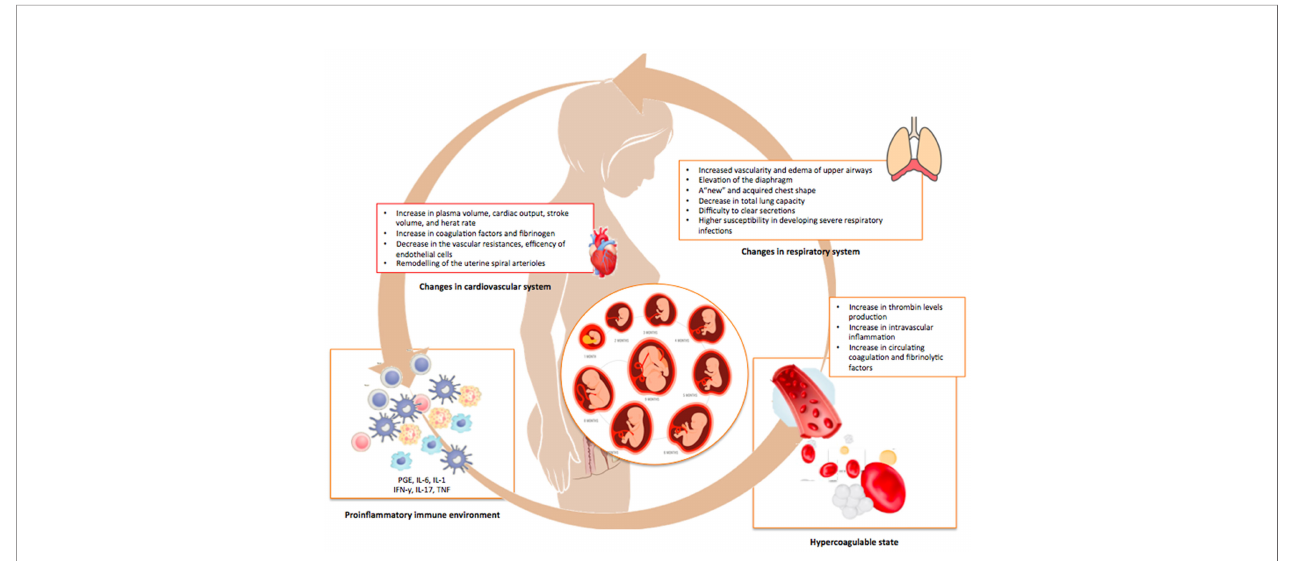
FIGURE 1 | Physiologic adjustments occurring during pregnancy. This illustration summarizes the multiple and profound changes in the immune, pulmonary, cardiovascular, and coagulation systems of the mother occurring during normal pregnancy in order to avoid rejection and promote the growth of the